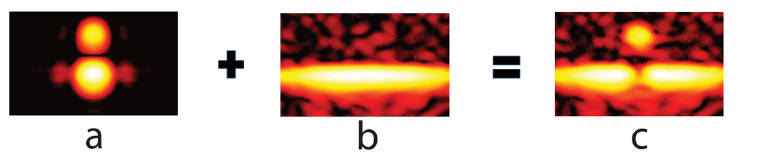
Figure 3. ( c ) An example representation for signal-level combination for a noise-free defect simulation and defect-free experimental noise. ( a ) Simulated noise-free defect. ( b ) Experimentally measured defect-free noisy back wall